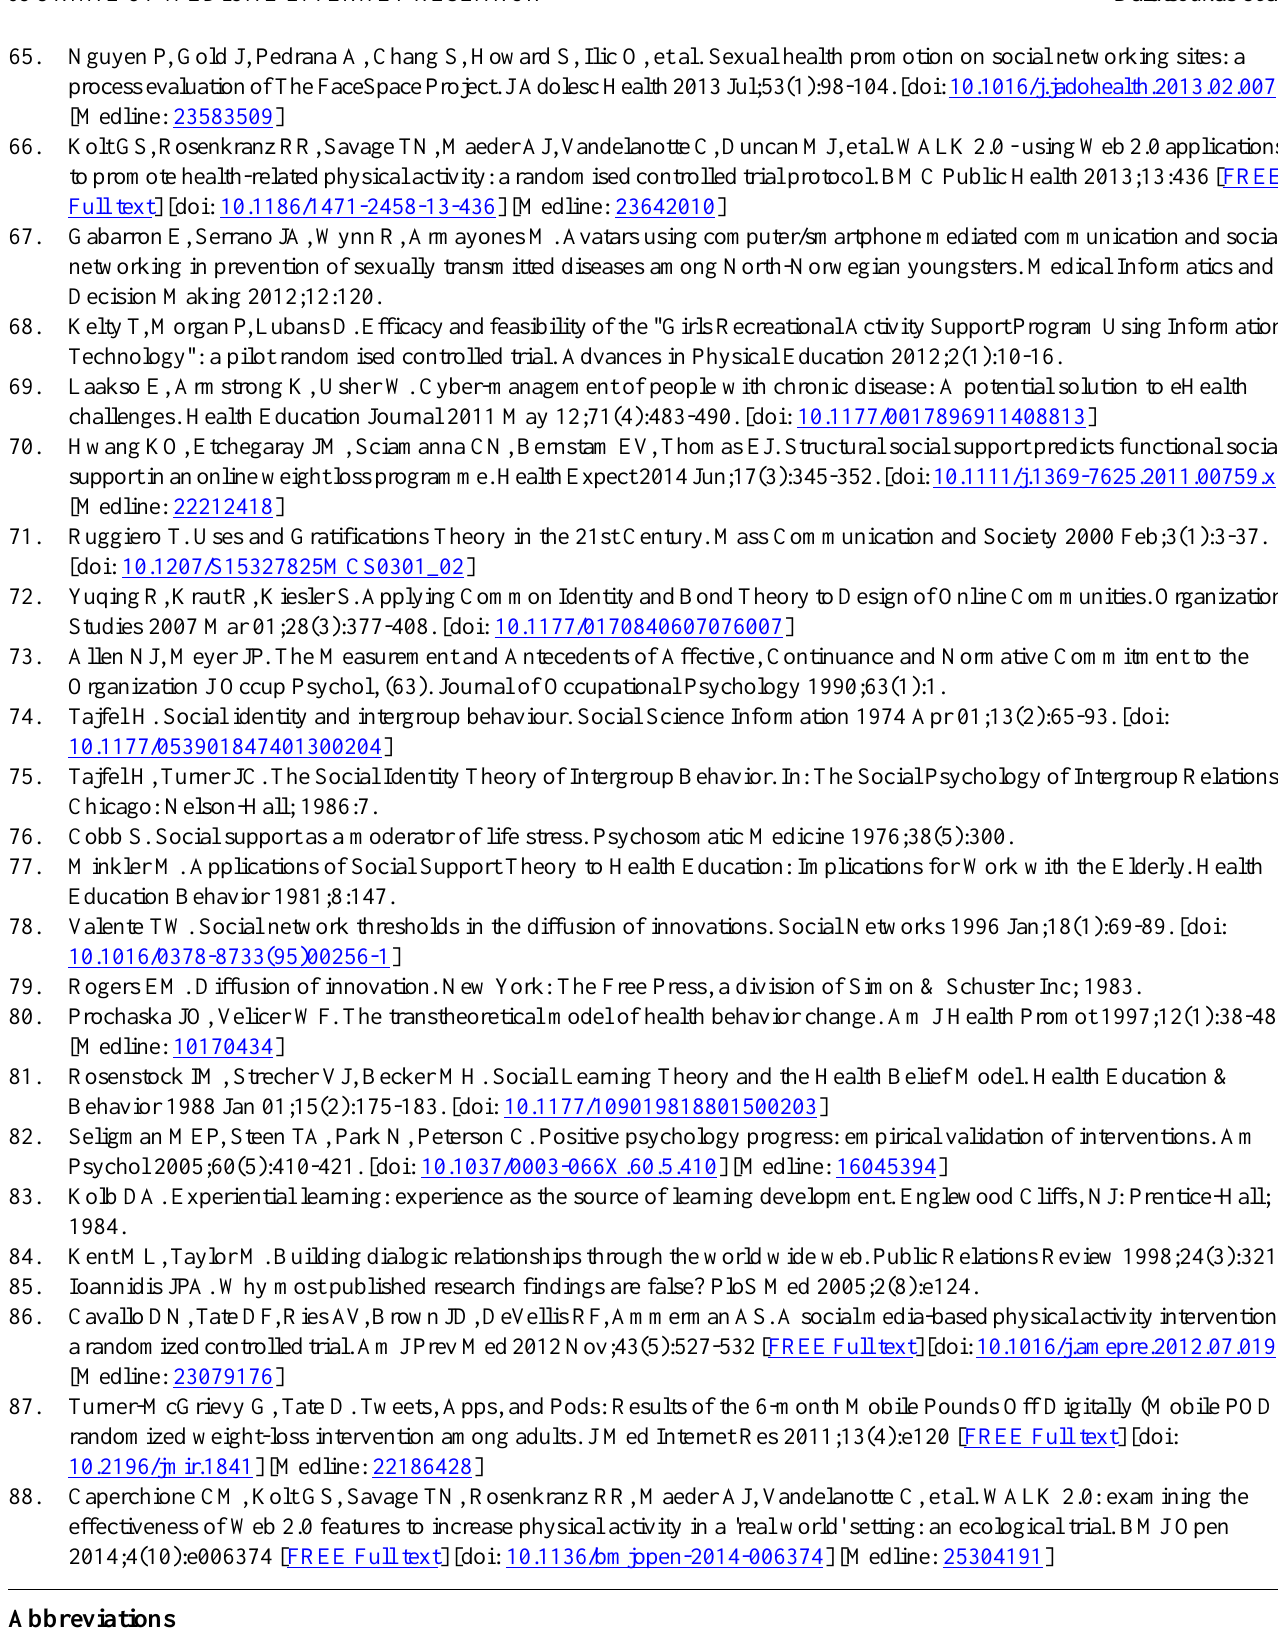
DI: Diffusion of Innovation